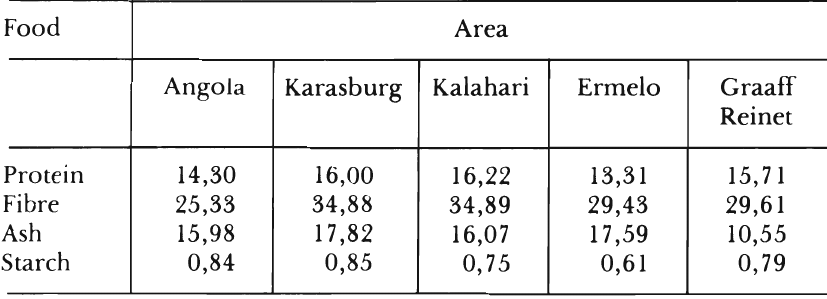
Analyses of rumen digesta from all the springbok in each area given as a per centage of the total food